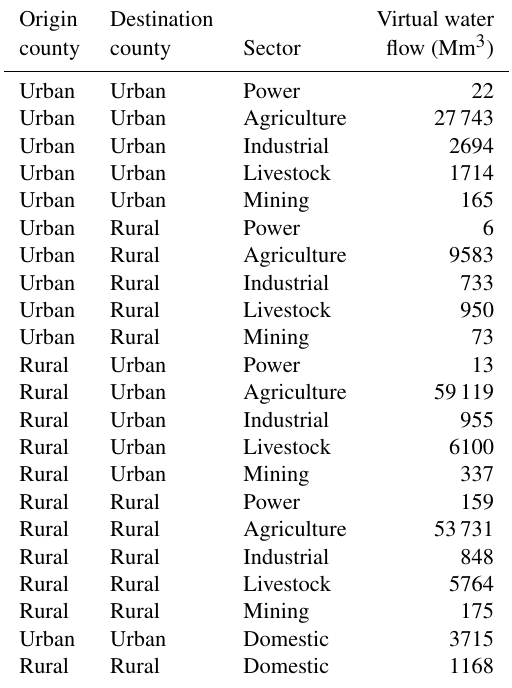
Table 4. Urban–rural blue virtual water transfer by economic sector (Mm 3